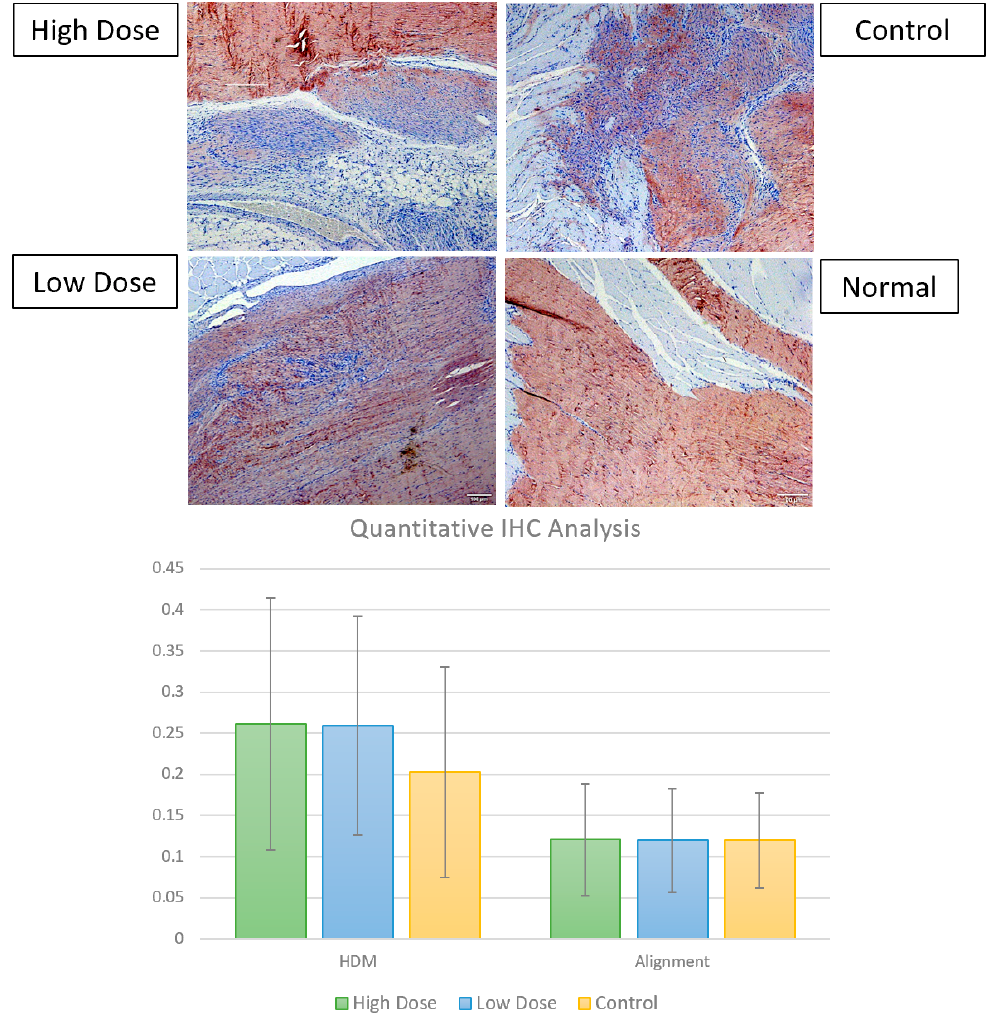
Figure 10. Collagen Type I immunostaining of rat Achilles tendon 30 days after tendon injury and treatment compared to normal, uninjured rat Achilles tendon. Scale bar = 100 μ m. Quantitative TWOMBLI metrics of the high-density matrix and matrix alignment for the high dose, low dose, and injured control groups are presented in the chart above, conveyed as ratios of high-density matrix to total matrix and ratios of aligned fibers to total fiber content, respectively. No significant differences in the quantitative analysis of collagen I IHC were noted between treatment groups.